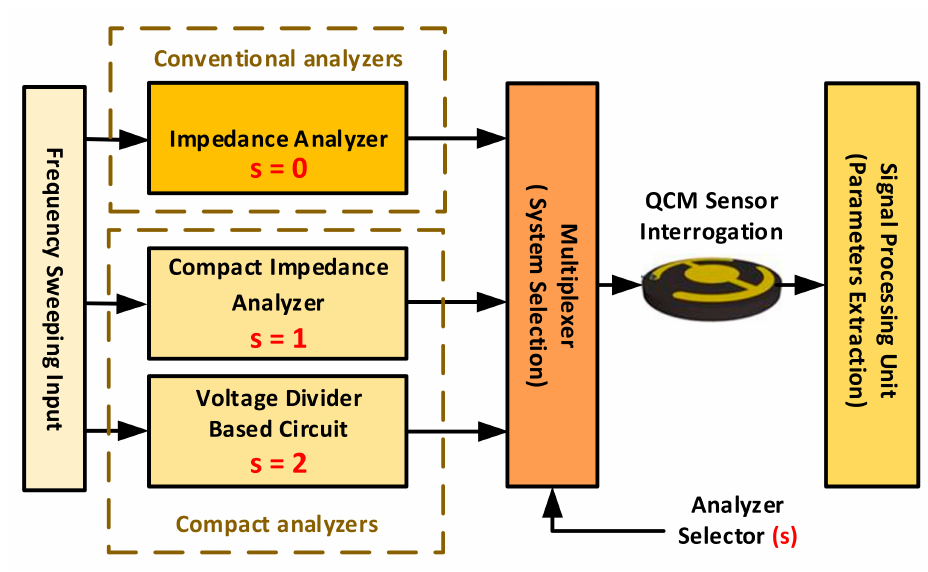
Figure 6. Different types of impedance-based measurement systems in